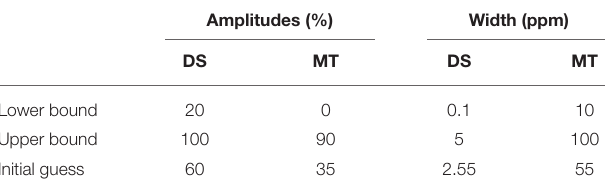
TABLE 2 | Initial estimates and bounds for Lorentzian fit of CEST